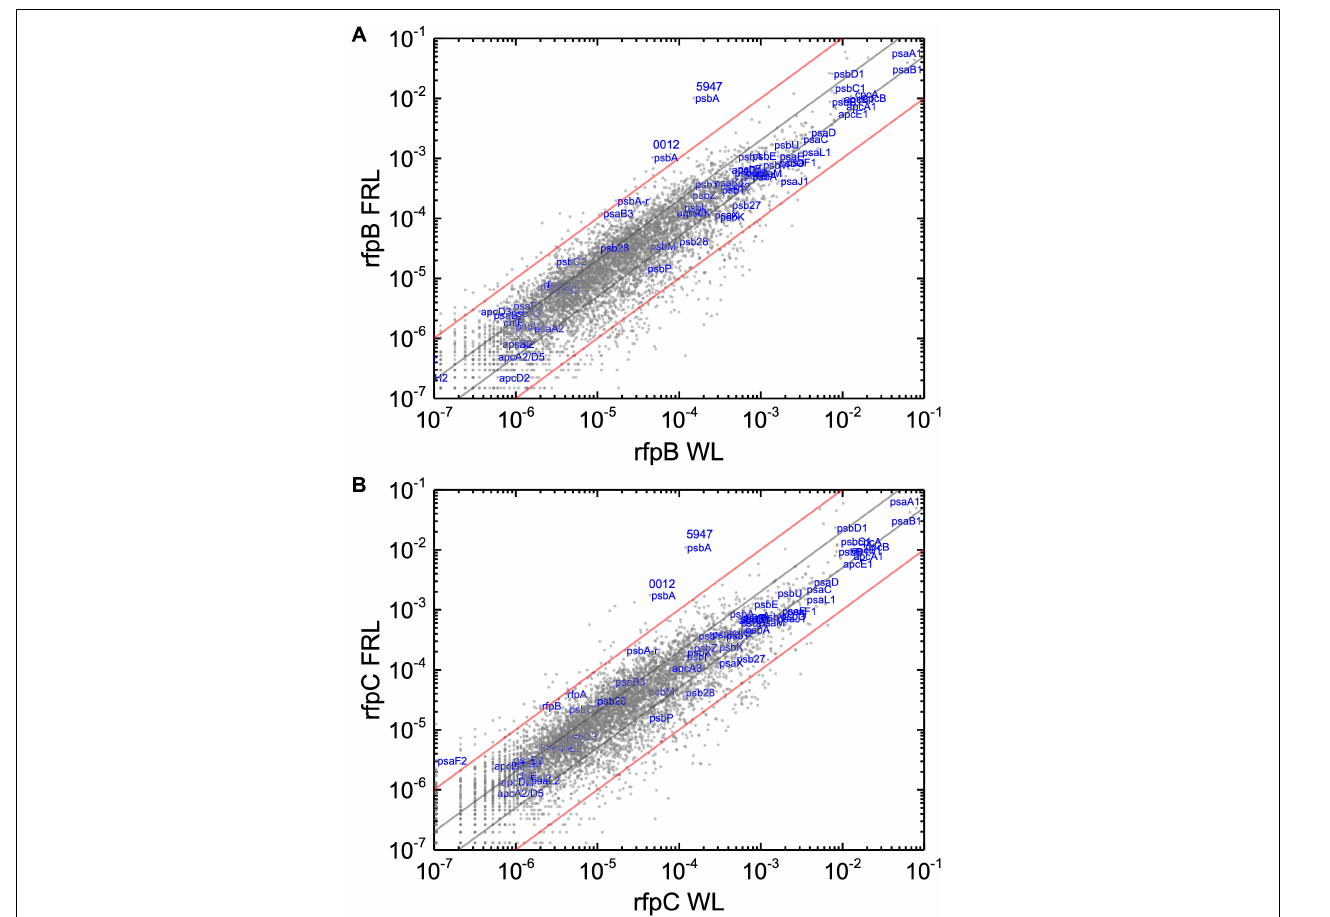
FIGURE 7 | Scatter plots showing a comparison of relative transcript abundances for C. fritschii 9212 cells of the rfpB and rfpC mutants and WT grown in FRL and WL. The X - and Y -axes represent normalized transcript abundances in the (A) rfpB mutant and (B) rfpC mutant grown in FRL and in WL, respectively. Each gray dot represents one gene. Genes of interest, including genes in FaRLiP gene cluster and genes encoding PSI, PSII, and PBP/PBS subunits are labeled in blue. Two psbA genes (UYEDRAFT_00012 and UYEDRAFT_05947) are labeled as 0012 and 5947, respectively. The gray and red diagonals indicate the thresholds for a 2-fold and 10-fold increase and a 50 and 10% reduction in relative transcript abundance,